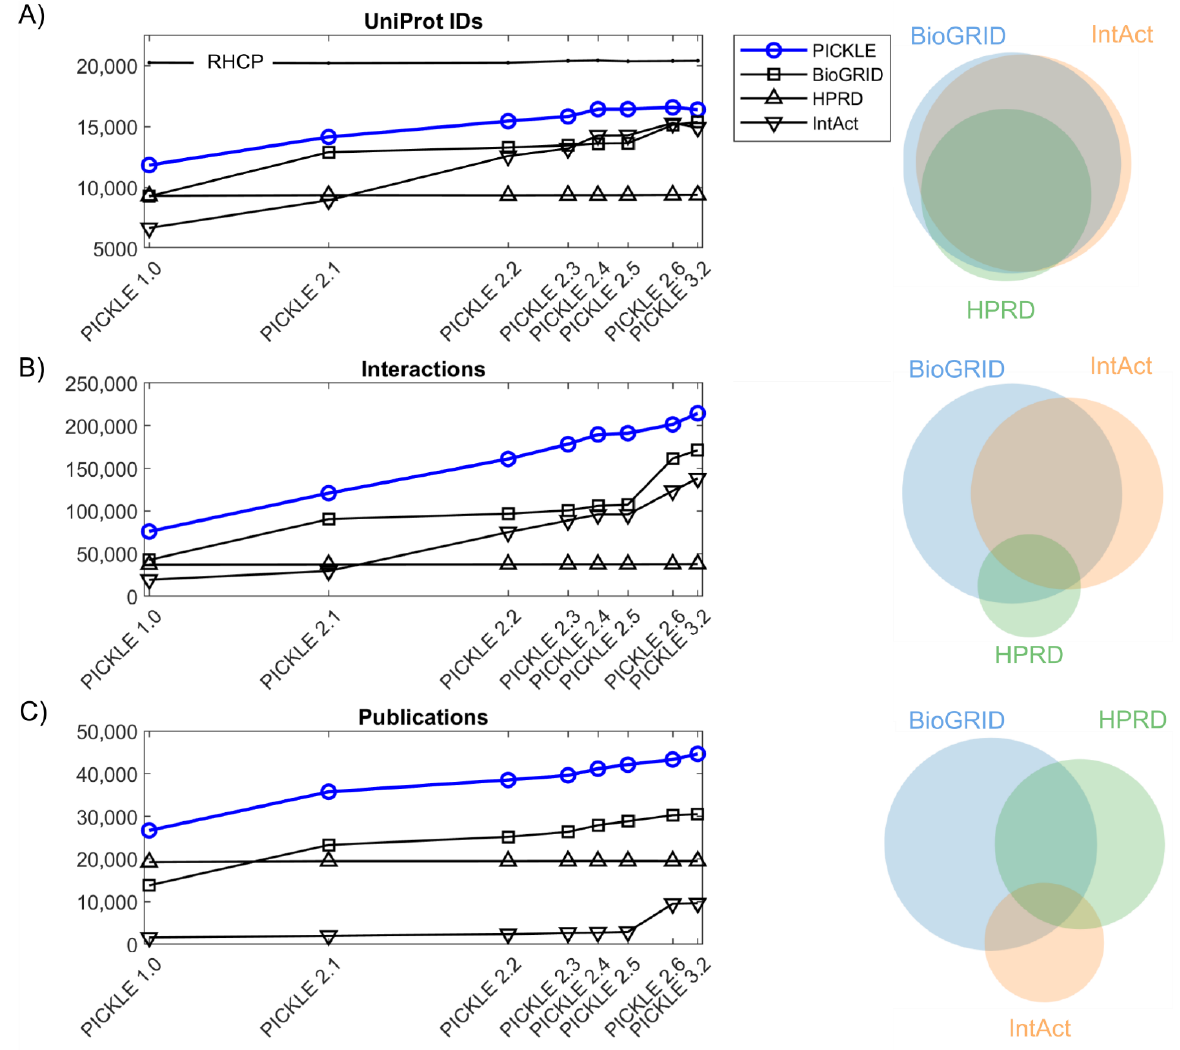
Figure 1. The expansion of the human protein interactome in terms of ( A ) proteins; ( B ) protein interactions; ( C ) supporting publications, based on PICKLE successive releases. The corresponding expansion of the primary PPI datasets integrated in PICKLE is also shown. The Venn diagrams on the right depict the relevant overlap between the primary datasets in PICKLE 3.2. It is noted that since PICKLE 2.6, the meta-database integrates the full IntAct dataset, while in the previous versions only the IntAct and MINT-annotated PPIs were incorporated from IntAct; DIP was integrated as a separate set from its original resource.